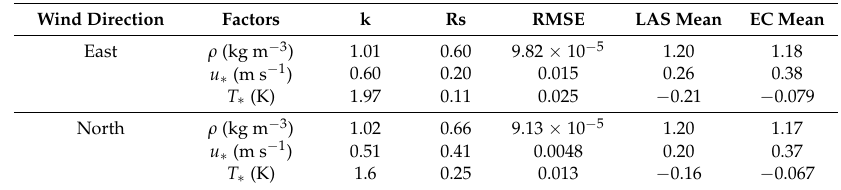
RMSE: square error of factors’ regression; LAS: averaged measurement from LAS; EC: averaged measurement from